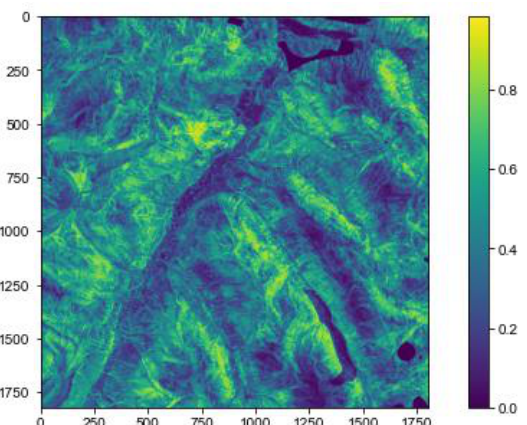
Figure 5. The spatial distributions of the avalanche probabilities obtained from the